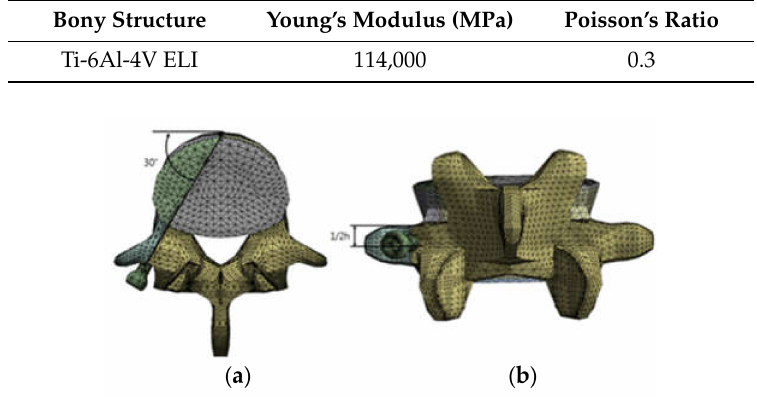
Figure 6. Integrated FEA model with L4 and pedicle screws: ( a ) Top view with insertion angle and ( b ) posterior view with insertion